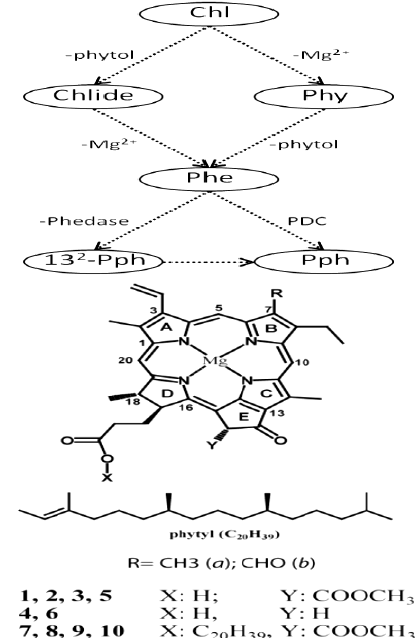
Fig. 1. The early degradation steps of chlorophyll in the insect alimentary tract and the basic structure of its derivatives. Chl is degraded by chlorophyllase – loss of phytol; and by a metal-chelating substance - loss of Mg 2+ : producing Phe. Pheophorbidase and pheophorbide demethoxydecarbonylase (PDC) producing